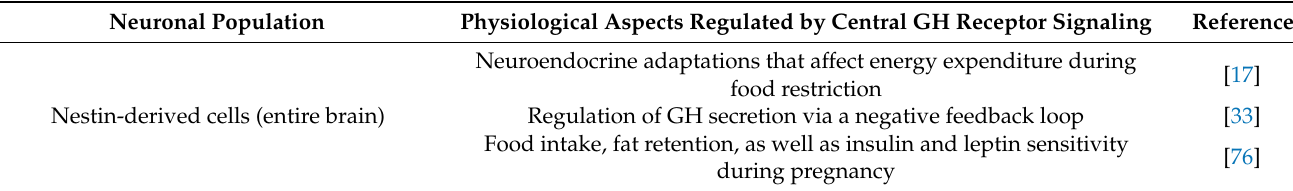
Table 1. Summary of the published articles that used mouse models with ablation of GH receptor in specific neuronal populations to investigate the physiological role of central GH action. Neuronal Population